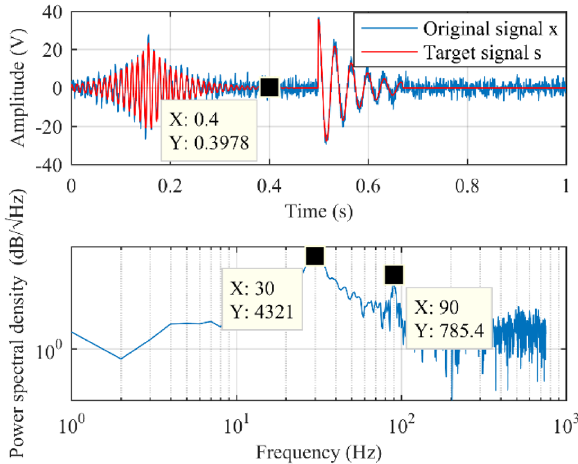
Figure 6. Waveform of the testing signal. The upper and lower subplot denote the time domain and frequency domain waveforms, respectively; red and blue lines in the upper subplot denote the original signal x and the target signal s = s 1 + s 2 ,